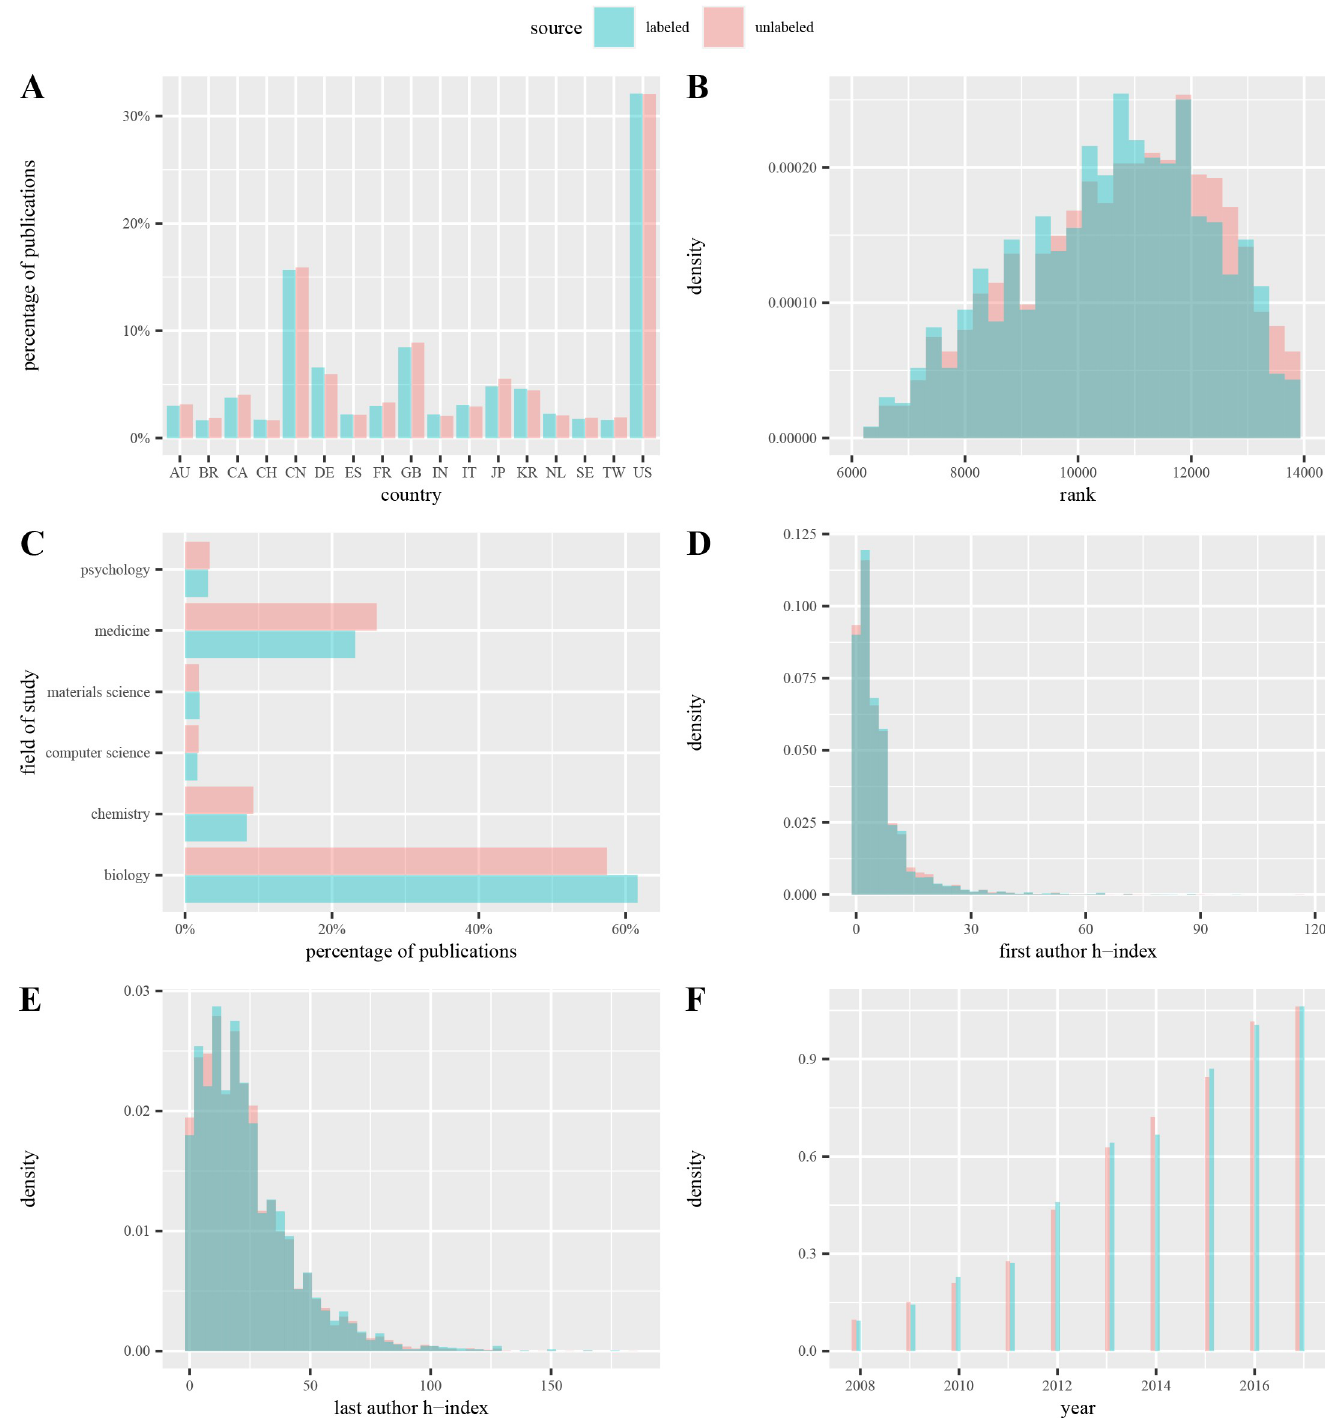
Fig 2. Labeled vs. unlabeled data. Features of both datasets are nearly identical. The prediction dataset could provide a reasonable estimation of the more general problems of graphical integrity.